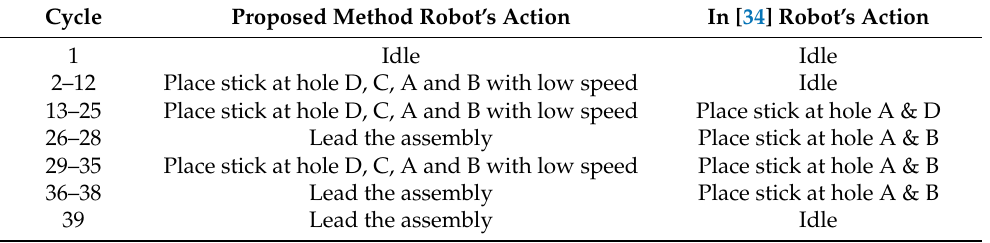
Table 12. Adaptation Ability